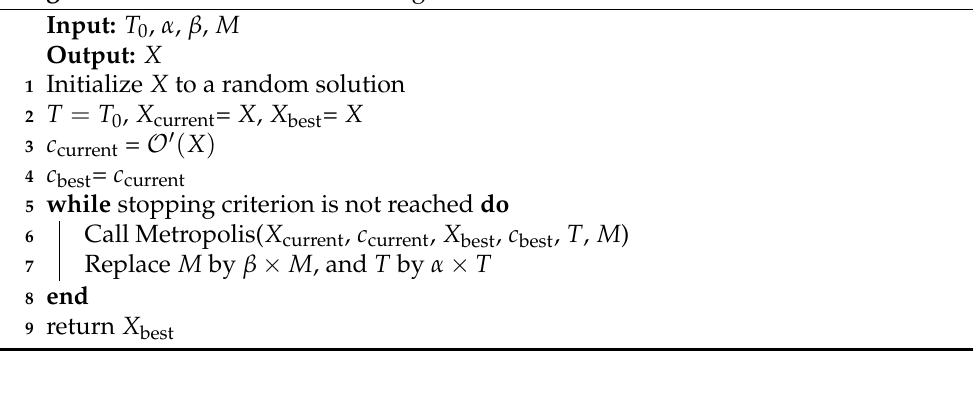
Algorithm 4: Overview of the SA algorithm.